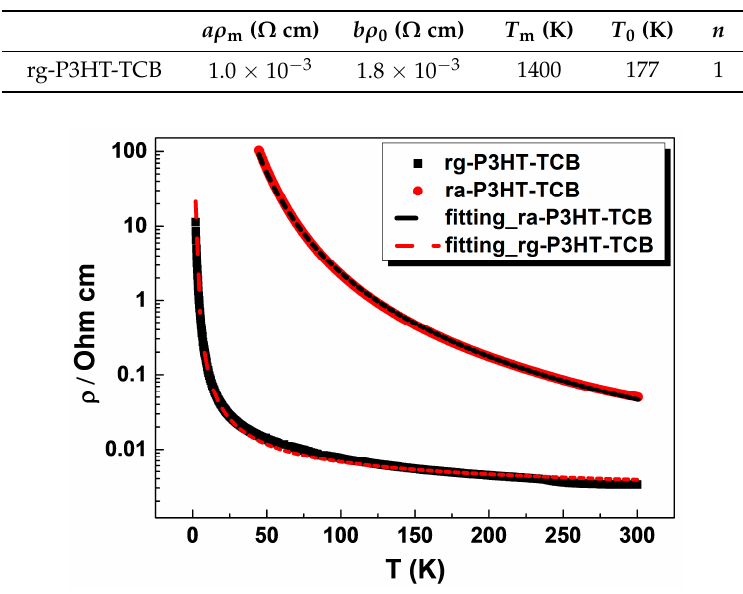
Figure 8. The characteristic temperature dependence of the resistivity of ra-P3HT-TCB and Figure 8. rg-P3HT-TCB films. The resistivity of ra-P3HT-TCB fits well with the variable range hopping